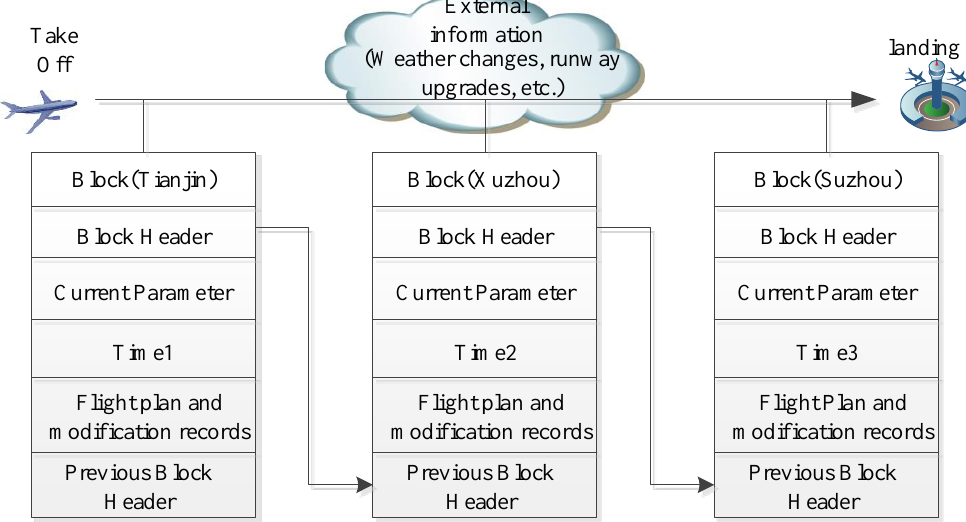
Figure 12. The storage structure of the blockchain.